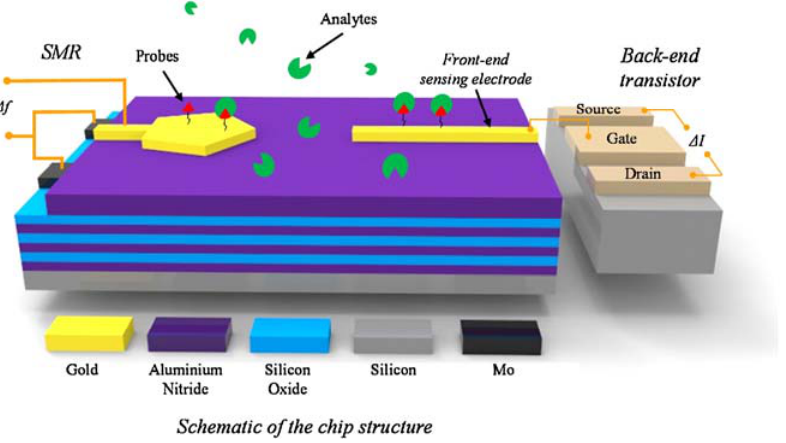
Figure 8. System used in the dynamic analysis of the interaction between anti-PSA and native human PSA. Reprint by permission from Elsevier.